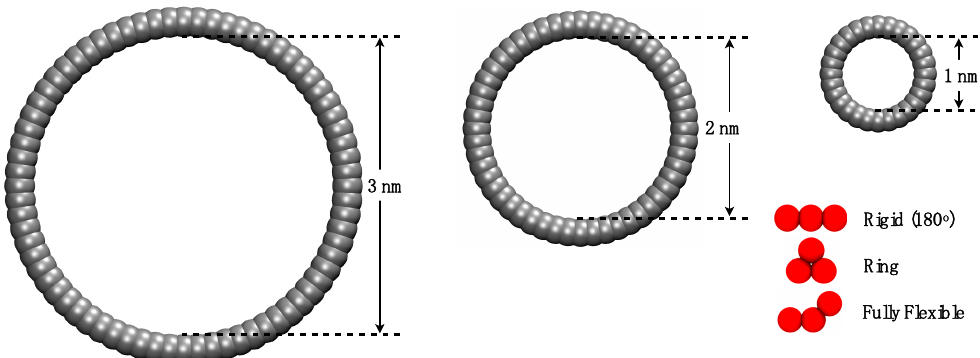
Figure 3. Representation of the pores and molecules employed, drawn to scale. Diagram shows the convention employed to define the inner pore diameter.